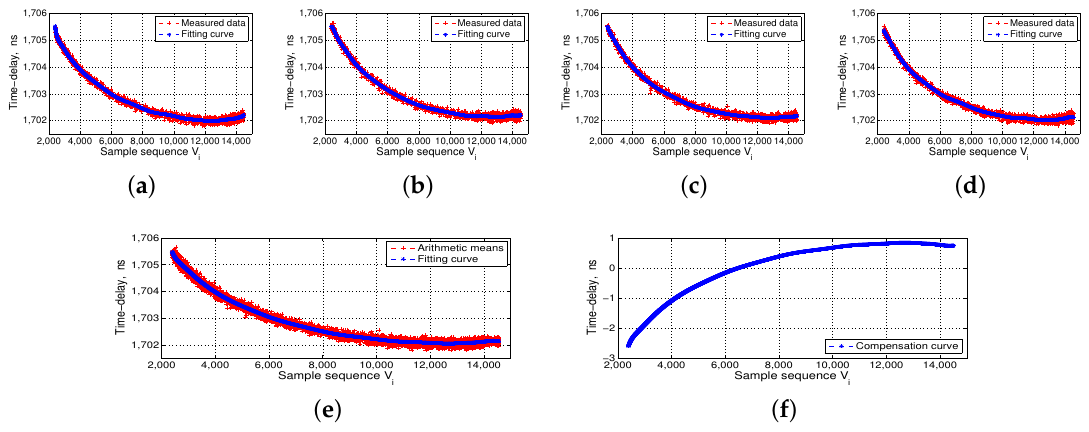
Figure 9. Radio frequency (RF) channel transmission-delay measurement data preprocessing. ( a – d ) the transmission-delay data measured four times and the corresponding fitting curves; ( e ) the arithmetic means of delay data measured four times and the corresponding fitting curves; and ( f ) the final transmission-delay compensation curves of the RF channel.